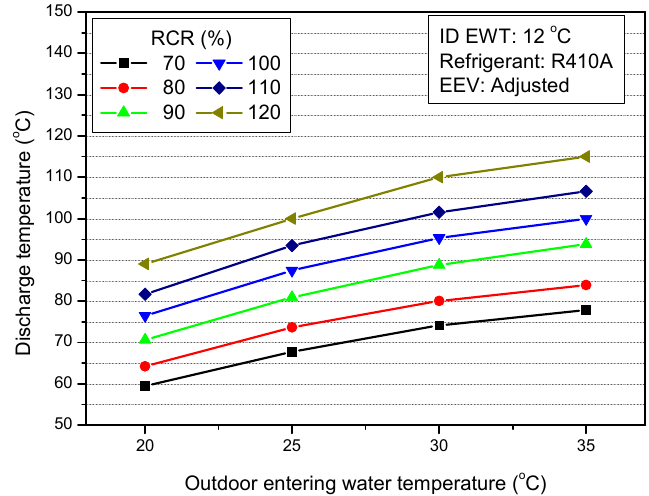
Figure 25. Condensing temperature with variation of T (cid:2899)(cid:2888) in cooling mode.